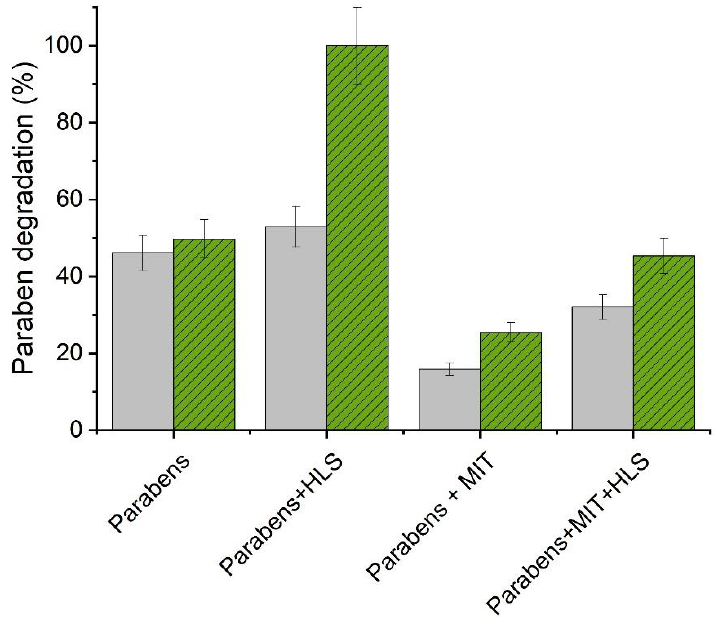
Figure 7. Percentage degradation of parabens after two hours in the presence and absence of MIT and HLS using half the concentration of hydrogen peroxide (grey) vs. using the total concentration of hydrogen peroxide (green with stripes).